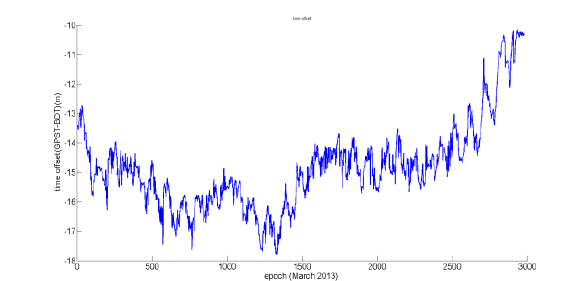
Figure 2 Time offsets (GPST-BDT) Residuals in March 2013